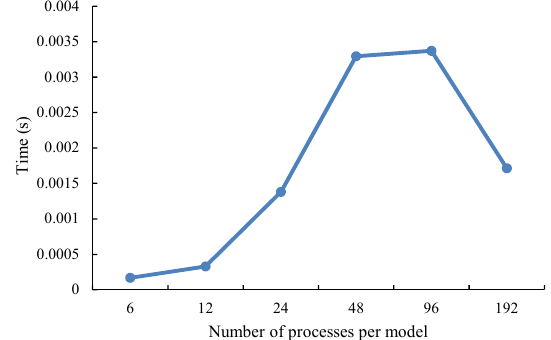
Figure 1. Average execution time of the P2P implementation when transferring 14 2-D fields from CLM3 to GAMIL2. In each test, the atmosphere model GAMIL2 and the land surface model CLM3 have the same number of processes; they do not share the same computing nodes. The horizontal grid of the 14 2-D fields contains 7680 (128 × 60) grid